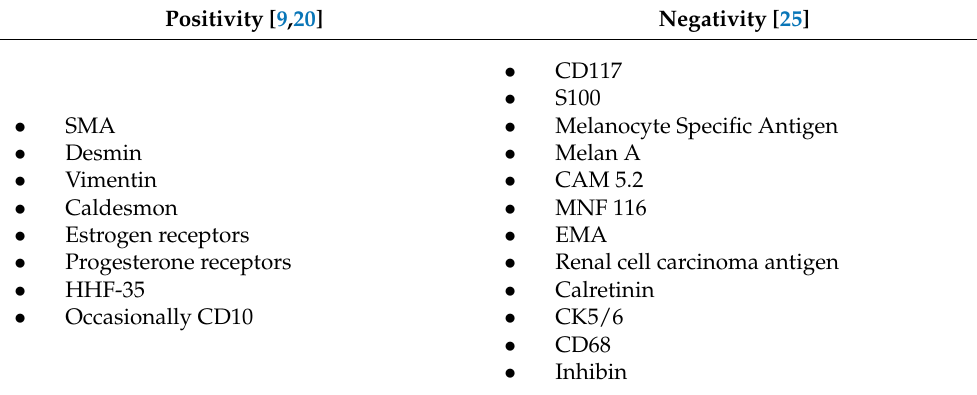
Table 4. The immunohistochemistry of cotyledonoid